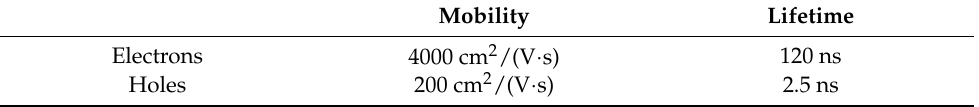
Table 1. Charge carrier transport properties of chromium compensated GaAs:Cr (2017) sensors from vendor #2. The parameter space of the electrons was confined by the product of mobility and lifetime that was obtained by the Hecht measurements ( µ · τ ) e = (4.730 ± 0.003) × 10 − 4 cm 2 /V ( ±